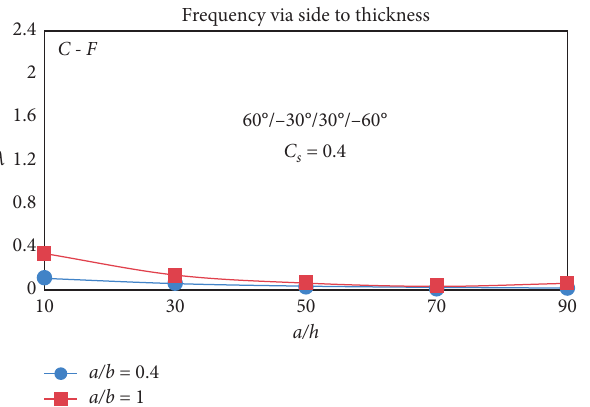
Figure 11: Impact of side-to-thickness ratio on frequency parameter value of 4-layered plates under C-F support condition.